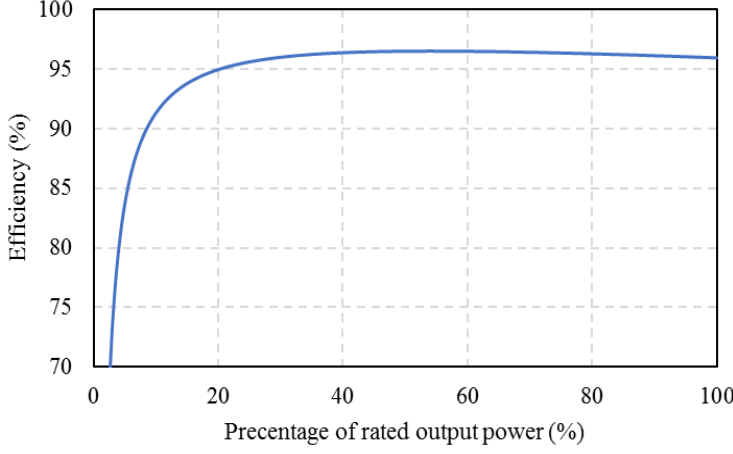
Figure 3. The efficiency of the SMA Sunny SB 6000 inverter along with the capacity ratio.